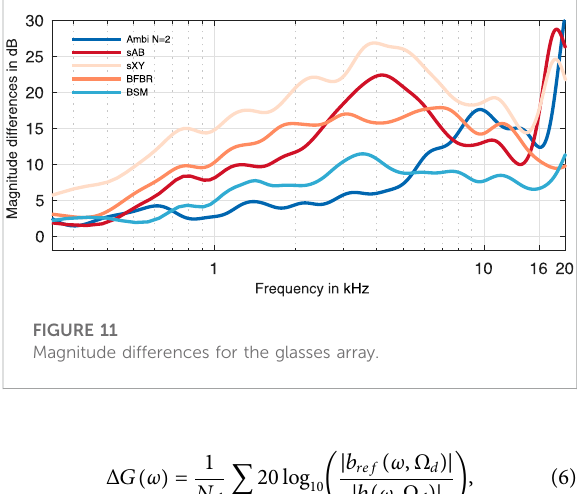
FIGURE 11 Magnitude differences for the glasses